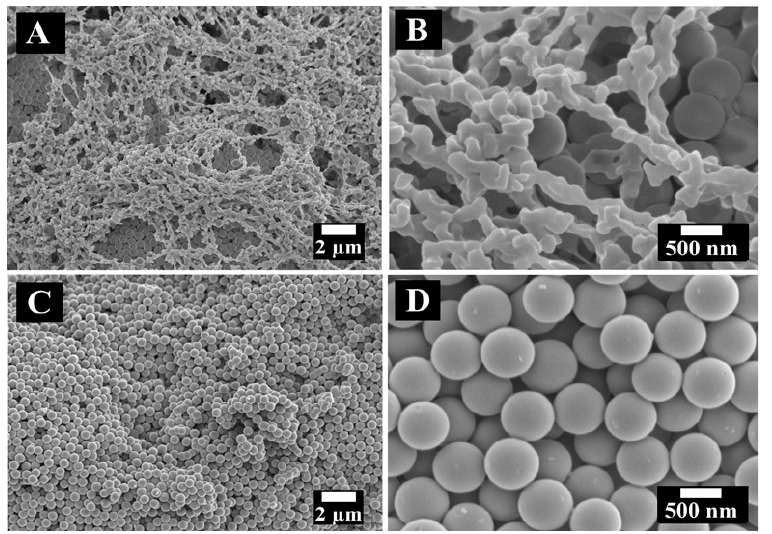
Figure 5. SEM micrographs at different magnifications for films prepared from 10 gL − 1 PEMA solutions in ethanol, containing 3 gL − 1 LA and 3 gL − 1 silica: ( A , B ) as deposited ( C , D ) annealed at 180 °C for one hour.